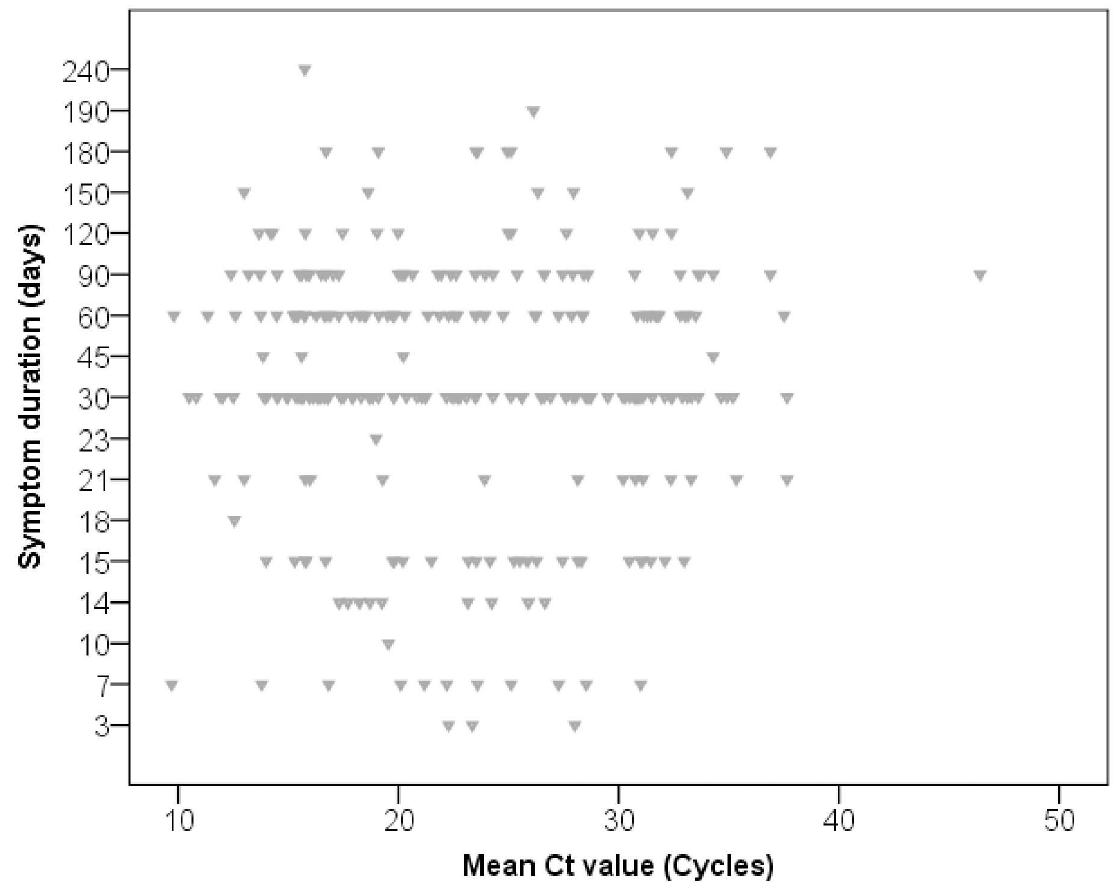
Fig 3. Scatterplotof individuals’mean CT value amongthosetestingXpertMTB/RIF positiveby reportedsymptom duration(SpearmanR 2 = 0.001,p = 0.612).